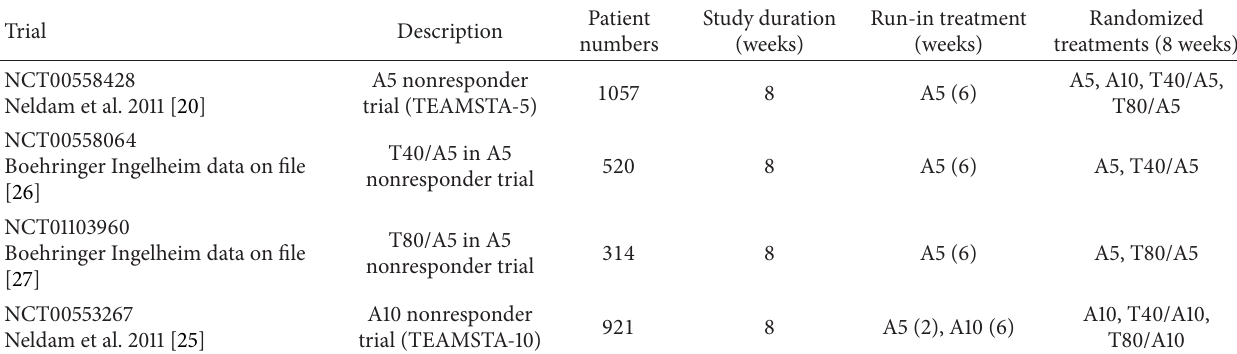
Table 1: Details of trials identified for inclusion into the